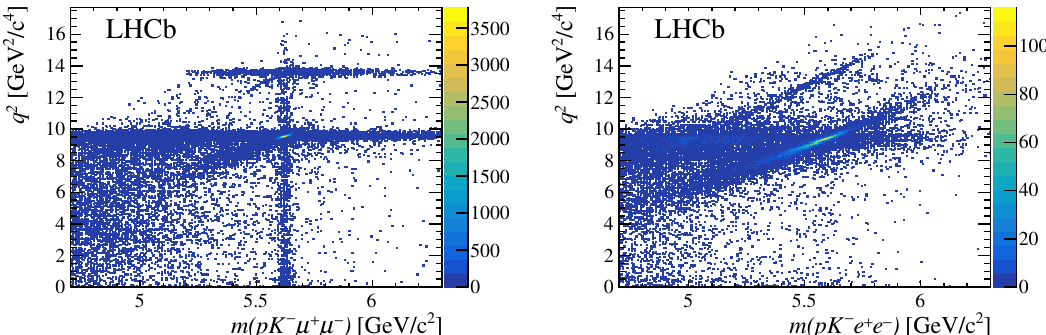
Figure 1. Distributions of dilepton invariant mass squared, q 2 , for (cid:3) 0 of pK (cid:0) ‘ + ‘ (cid:0) invariant mass, in data, for (left) ‘ = (cid:22) and (right) ‘ = e . The complete selection